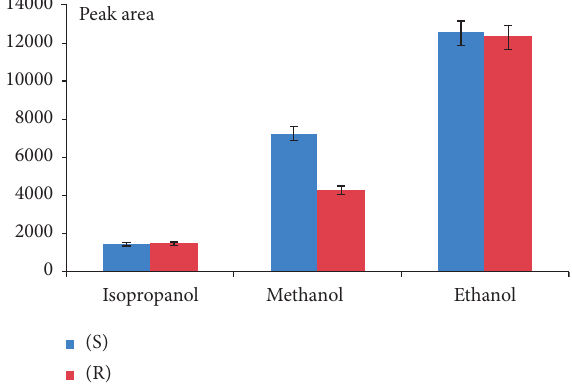
Figure 2: Effect of elution solvent on extraction efficiency (C8, sample conc. 0.05 µ g · mL − 1 ).